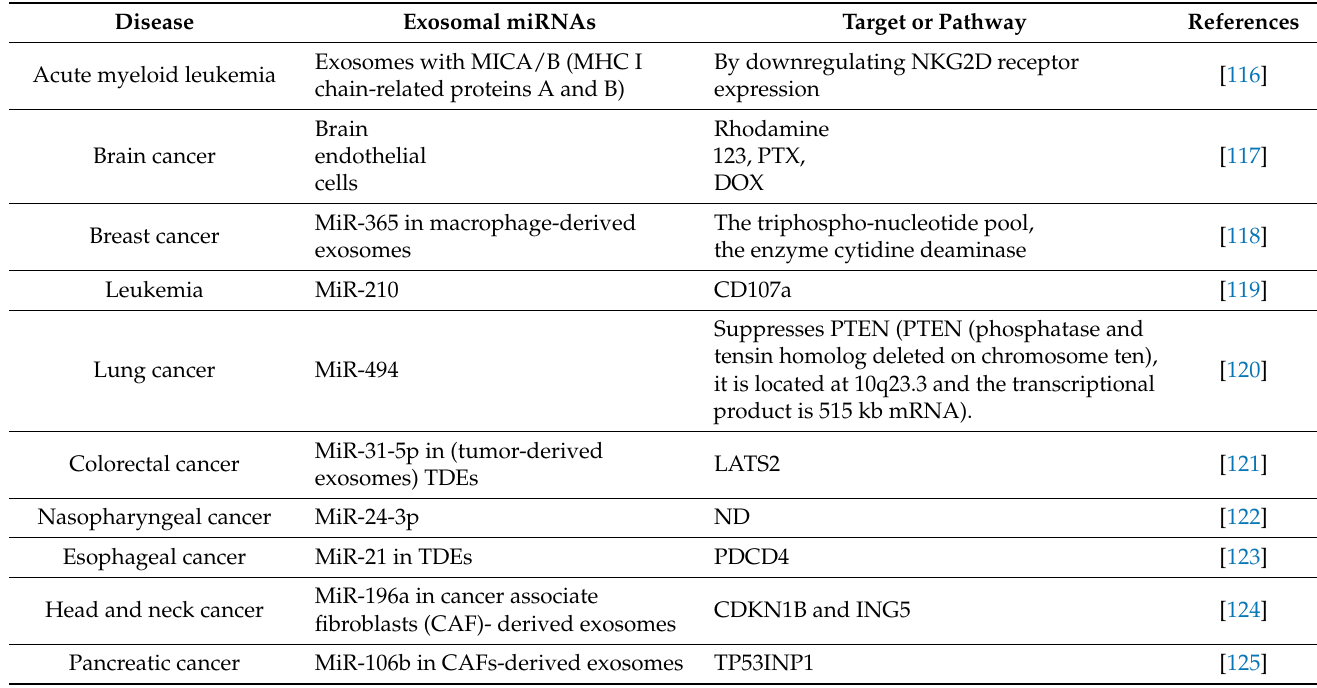
Table 2. The targets of exosomes in